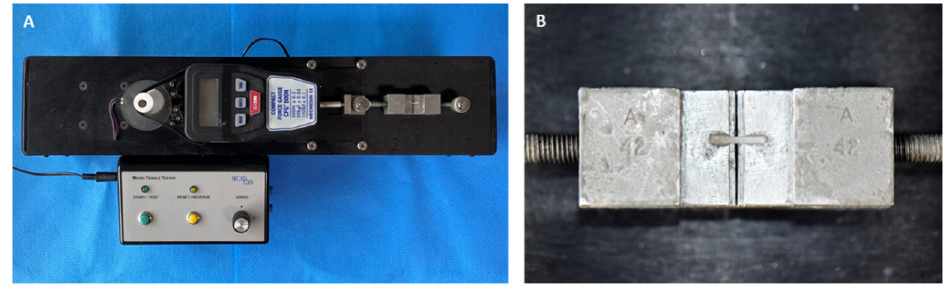
Figure 3. ( A ) μ TBS tester. ( B ) Specimen is mounted on the specimen holder.